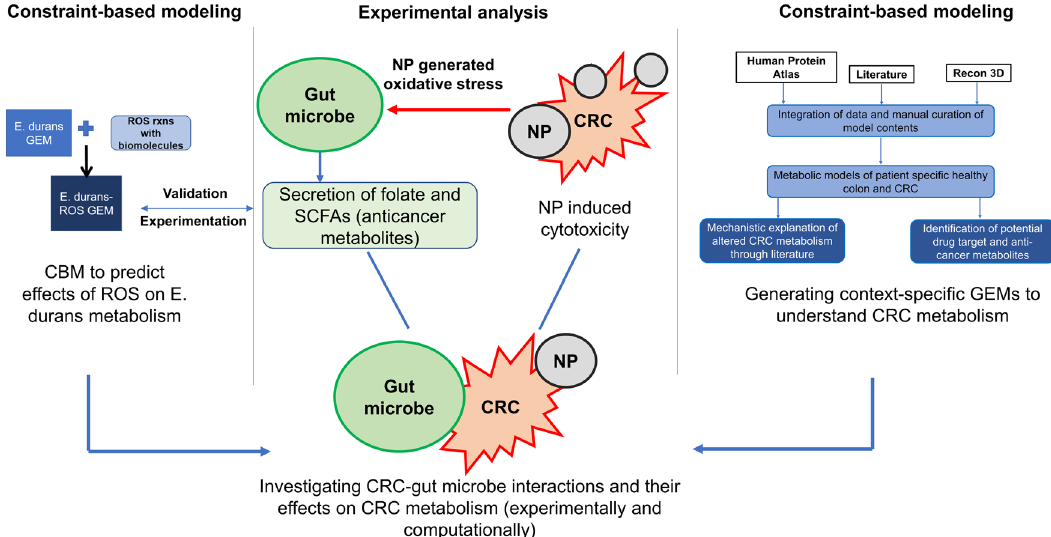
Fig. 1 An overview of the direct and indirect effects of AgNPs mediated oxidative stress on gut bacterial metabolism in treatment and management of CRC. AgNPs are known to mediate their direct cytotoxic effects through increased generation of reactive species inside the target cells. Besides, the AgNP-generated oxidative stress can also affect the cellular metabolism and certain pathways of interest (in this case, the anti-cancer metabolites) thereby enhancing indirect cytotoxicity. Gut microbe-CRC interactions can further assist in understanding the role of gut bacterial metabolites (indirect effects of ROS) on CRC metabolism.